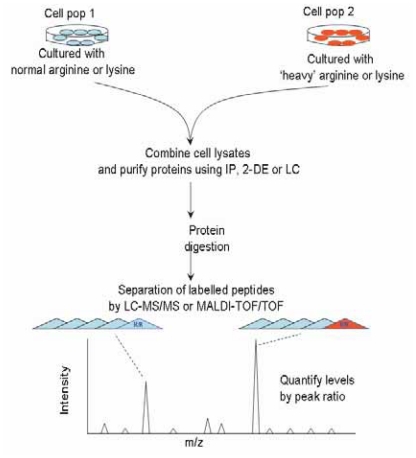
A schematic representation of the SILAC (‘stable-isotope labelling in cell culture’) method. A stably labelled amino acid in a cell-culture medium (in this case, ‘heavy’ arginine or lysine) is incorporated fully into the proteome of one cell population (“Cell pop 2”). Relative quantification experiments can easily be carried out using cells that were grown in normal media as the control (Cell pop 1). Cell lysates from two conditions can be combined and purified through many steps. The proteins are then digested and if the two forms of the peptides co-elute, a peptide ratio can be obtained for each mass spectrum, which allows the protein levels in the two populations to be quantified relative to each other.